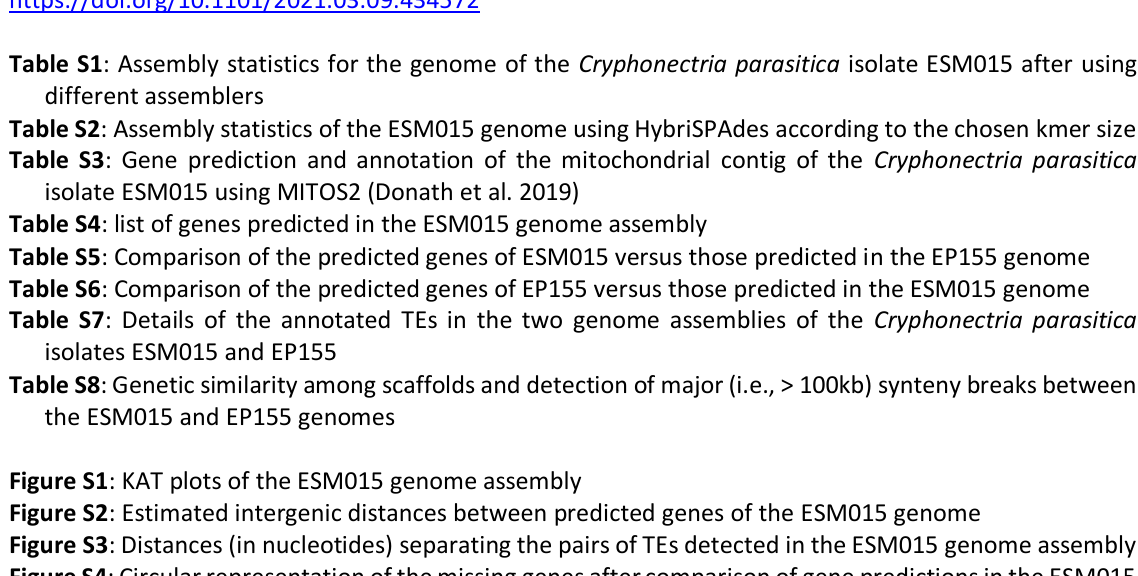
Table S1 : Assembly statistics for the genome of the Cryphonectria parasitica isolate ESM015 after using different assemblers Table S2 : Assembly statistics of the ESM015 genome using HybriSPAdes according to the chosen kmer size Table S3 : Gene prediction and annotation of the mitochondrial contig of the Cryphonectria parasitica isolate ESM015 using MITOS2 (Donath et al. 2019) Table S4 : list of genes predicted in the ESM015 genome assembly Table S5 : Comparison of the predicted genes of ESM015 versus those predicted in the EP155 genome Table S6 : Comparison of the predicted genes of EP155 versus those predicted in the ESM015 genome Table S7 : Details of the annotated TEs in the two genome assemblies of the Cryphonectria parasitica isolates ESM015 and EP155 Table S8 : Genetic similarity among scaffolds and detection of major (i.e., > 100kb) synteny breaks between the ESM015 and EP155 genomes Figure S1 : KAT plots of the ESM015 genome assembly Figure S2 : Estimated intergenic distances between predicted genes of the ESM015 genome Figure S3 : Distances (in nucleotides) separating the pairs of TEs detected in the ESM015 genome assembly Figure S4 : Circular representation of the missing genes after comparison of gene predictions in the ESM015 and the EP155 genome assemblies Figure S5 : Violin plots of distances between TEs and all pairs of predicted genes or pairs of different classes of predicted genes (effectors predicted by EffectorP or secreted proteins predicted by SignalP), and secondary metabolites (SM) predicted by AntiSMASH). Figure S6 : estimated GC content in the ESM015 genome assembly Figure S7 : Circular representation of the genomic region around the mating type and their syntenic relationships between the ESM015 and EP155 genome assemblies Figure S8 : Visualization of the mapping of the Nanopore (ESM015) or Sangers (EP155) reads on the ESM015 and EP155 genome assemblies around the major detected synteny breaks Supplementary Material 1 : Protocol of DNA extraction for Nanopore long-reads genome sequencing Supplementary Material 2 : Curation of the TE databases Supplementary Material 3 : Statistics of the DNA extraction of the Cryphonectria parasitica ESM015